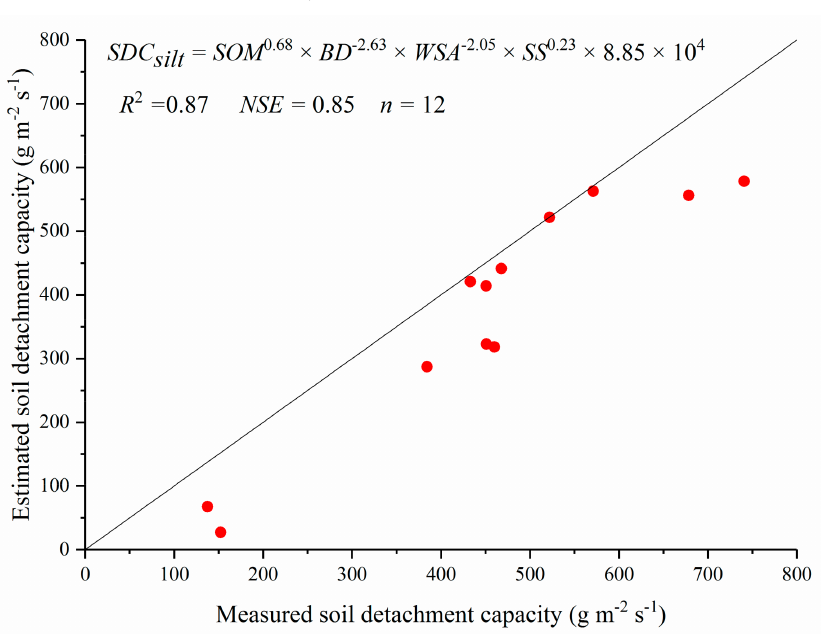
Figure 10. Measured soil detachment capacity vs. estimated ones using Equation (2) of silt